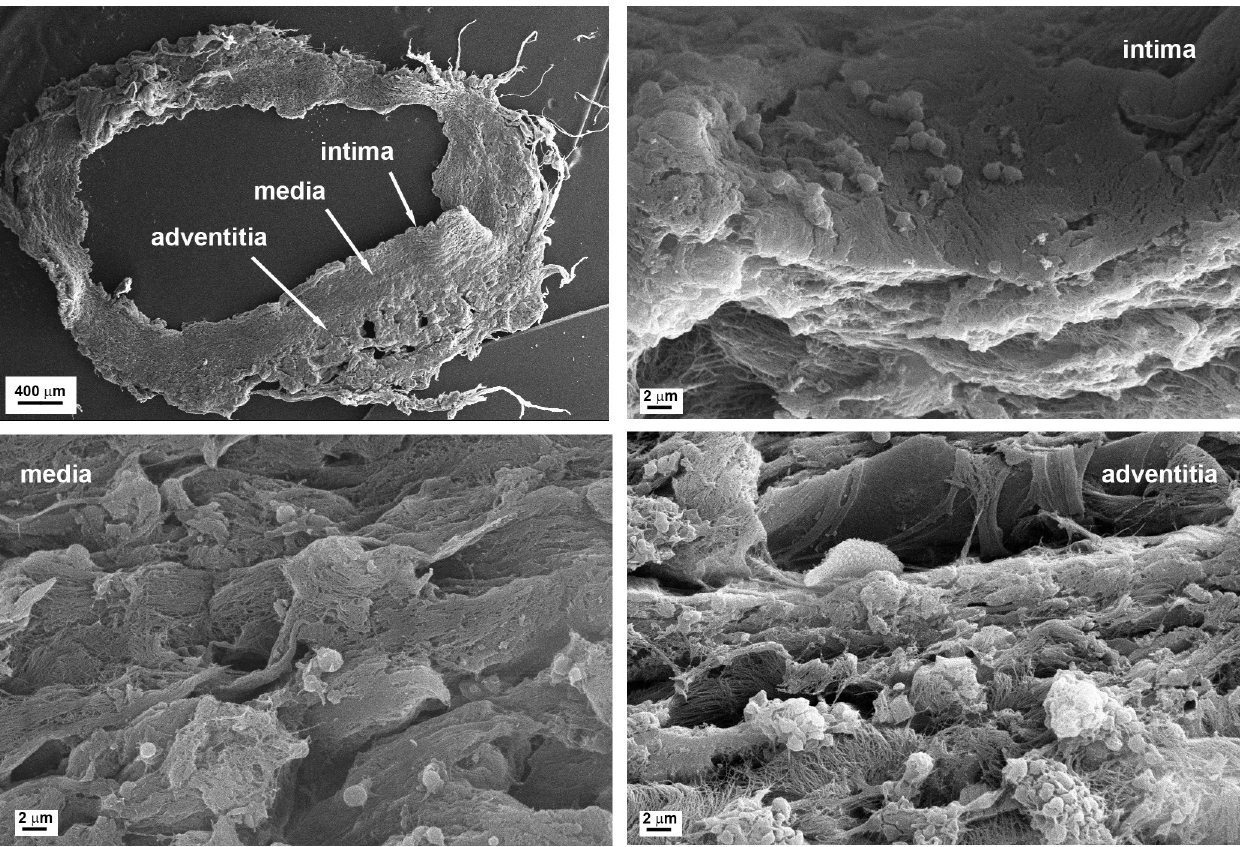
Fig 2. Platelet adhesion to arterial cross-sections. Cross-sections of the arterial grafts were prepared as described in the Materials and Methods (top left panel) and perfused with heparinized blood. Following the perfusion, the cross-sections were fixated and processed for scanning electron microscopic imaging. Isolated adhered platelets are seen in the intima and media layers, whereas larger aggregates are formed in the adventitia.